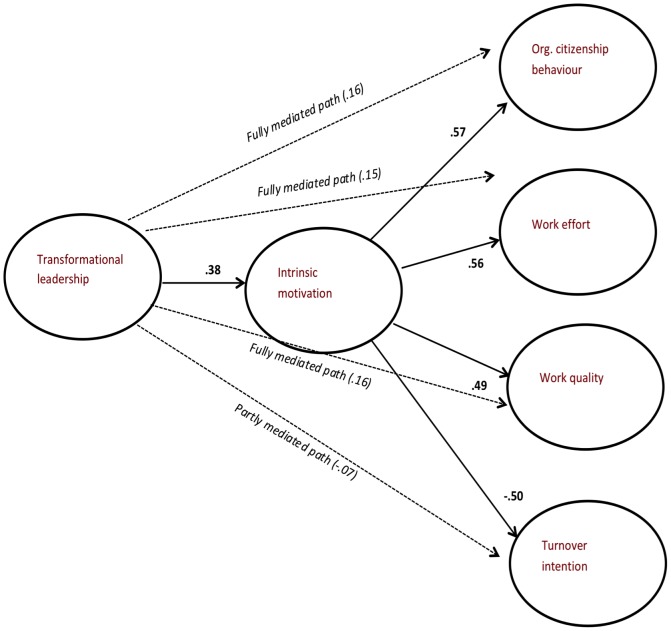
Direct and “mediated” semantic relationships between transformational leadership, intrinsic motivation and organizational outcomes (direct semantic relationships from transformational leadership to outcomes in brackets).